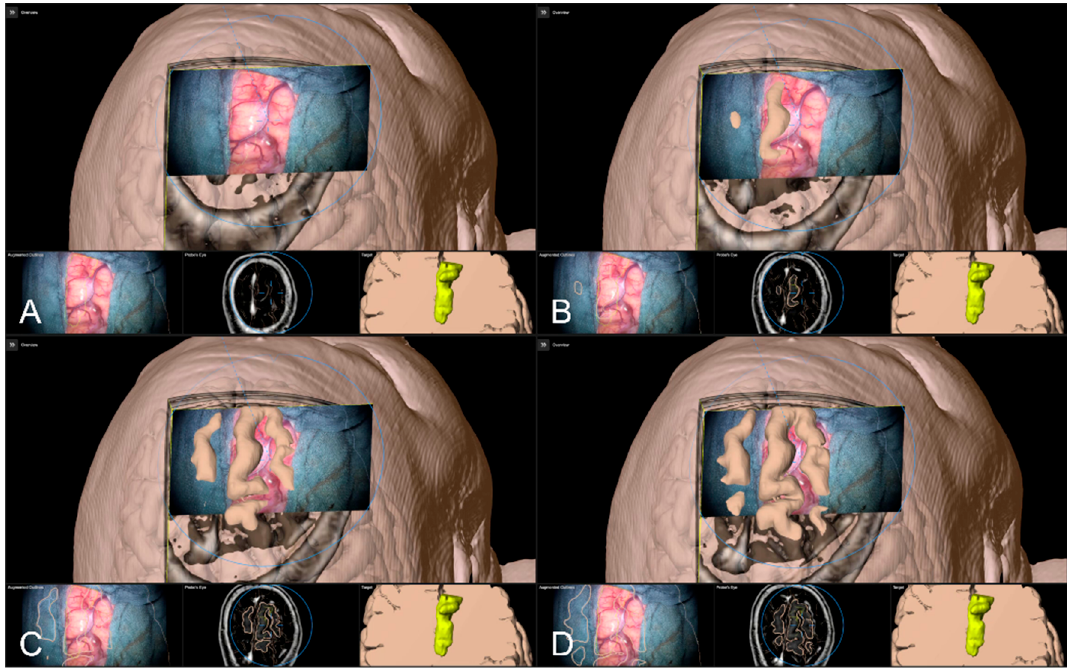
Figure 9. Superimposing the microscope video on the 3D visualization of patient MRI data including the pre-segmented objects (cerebrum and tumor) intuitively relating video frame and 3D anatomy (upper part in A – D ), in parallel view of AR-supported microscope view, probe’s eye view and target view (bottom part in A – D from left to right). Moving the focus plane (superimposed microscope video) along the optical axis of the microscope ( A – D ), the registration quality can be evaluated showing a sufficient match in this case.